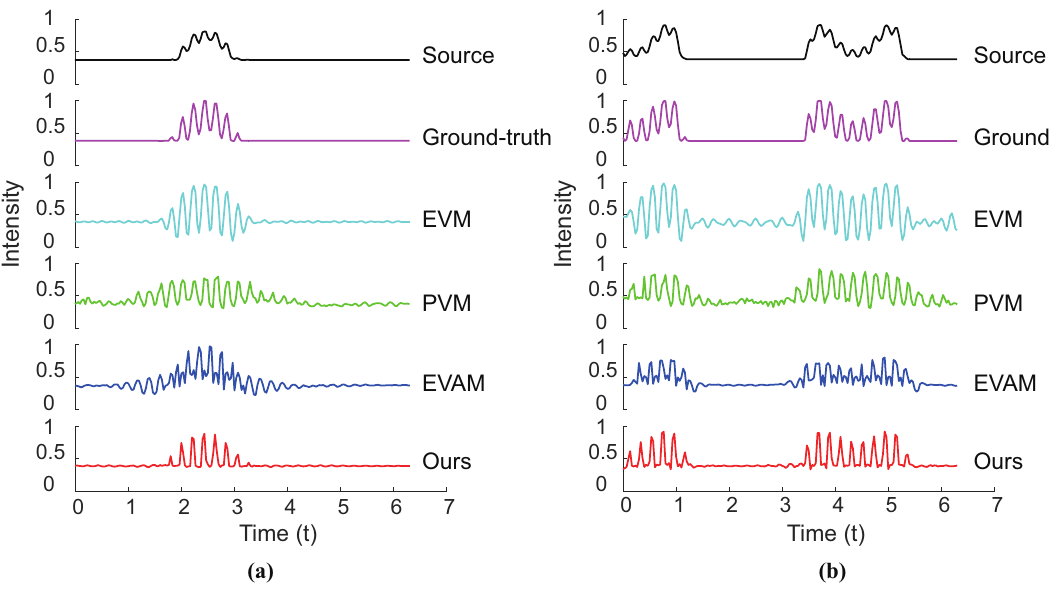
Figure 8. Ground-truth verification of our algorithm compared against other techniques. ( a ) The variation in intensity temporally at the position of the red point indicated in Figure 6. The original intensity values are delineated by the black curve, while the ground truth magnification is the magenta. Signals magnified using the linear Eulerian method [6], phase-based processing [12], acceleration magnification [17] and our algorithm are depicted in cyan, green, blue and red, respectively. Our algorithm magnifies the signal that best resembles the ground truth. ( b ) Results of signal magnification for the proposed algorithm and other methods at the location on the frame in Figure 7. The description of the magnified signal is similar to ( a ). The magnified signal shows that our approach outperforms all other techniques when the input video contains a nonlinear